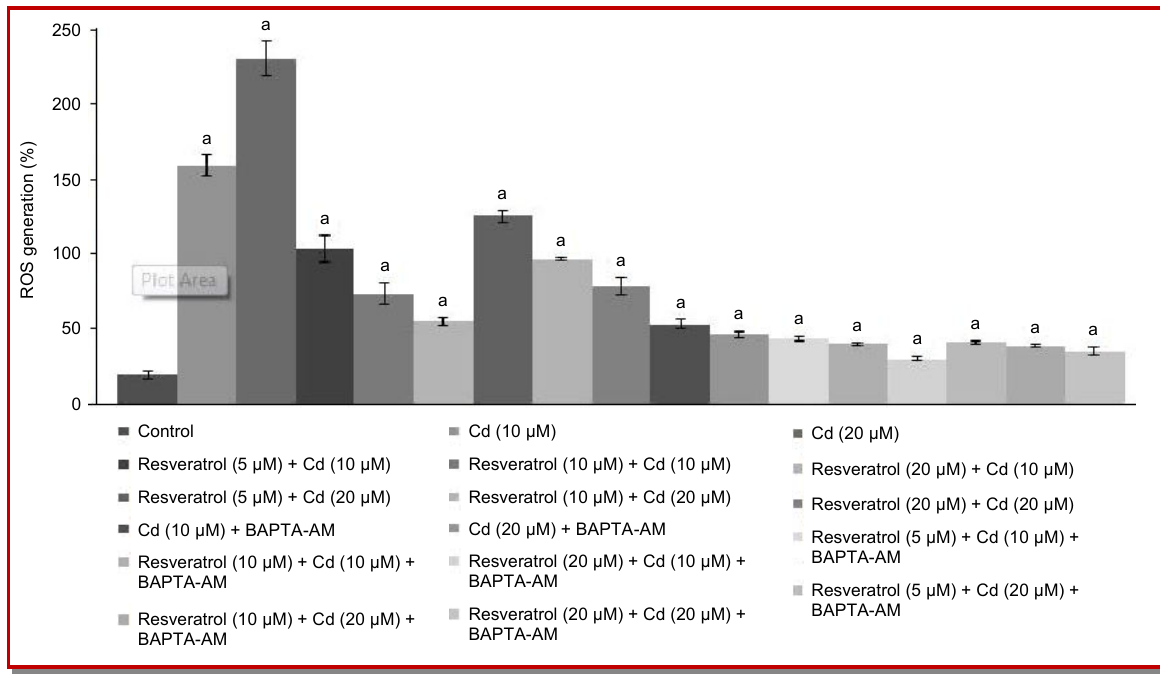
Figure 2: Resveratrol inhibits Cd-induced alterations in intracellular free calcium levels Resveratrol with/without BAPTA-AM or AMP treatment caused significant reduction in [Ca 2+ ] i levels; Values are represented as mean ± SD; n=6; a represents statistical significance at p<0.05 compared against control as determined by one-way ANOVA